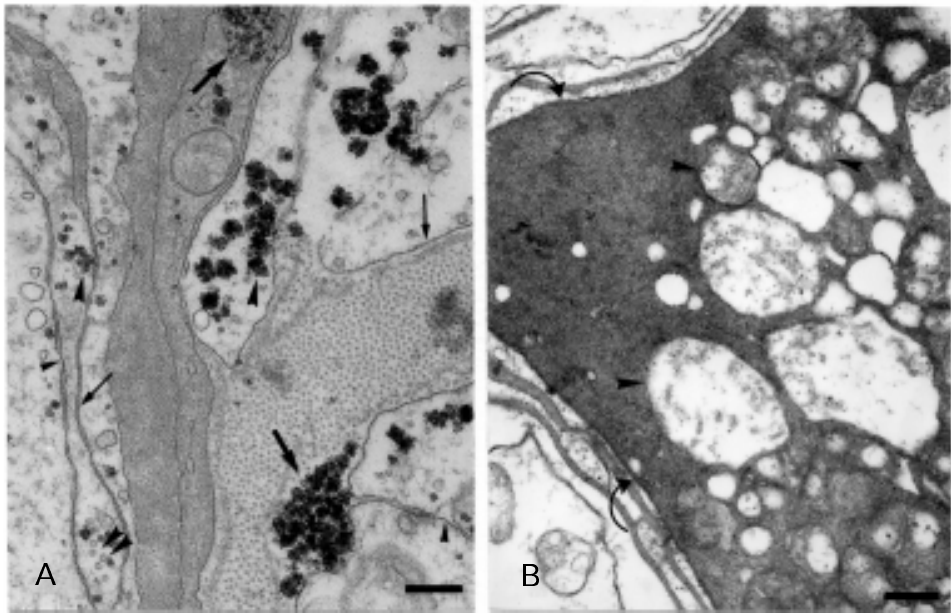
Figure 2 - A , Electron micrograph of the PT treated according to Thiéry showing glycogen aggre- gates in the cytoplasm of dark (large arrows) and light (large ar- rowheads) glial cell processes. Note that both the dark and the light processes clearly present a plasma membrane (thin arrows). Microtubules are observed in the light process (double small arrowheads) and also gap junc- tions (small arrowheads). Bar: 0.3 µm. B , Electron micrograph of the zona fasciculata treated according to Thiéry (11). The dark process displays mitochon- drial profiles in different degrees of disruption (arrowheads). Ob- serve a plasma membrane be- tween the dark and light pro- cesses (curved arrows). Bar: 0.4 µm.